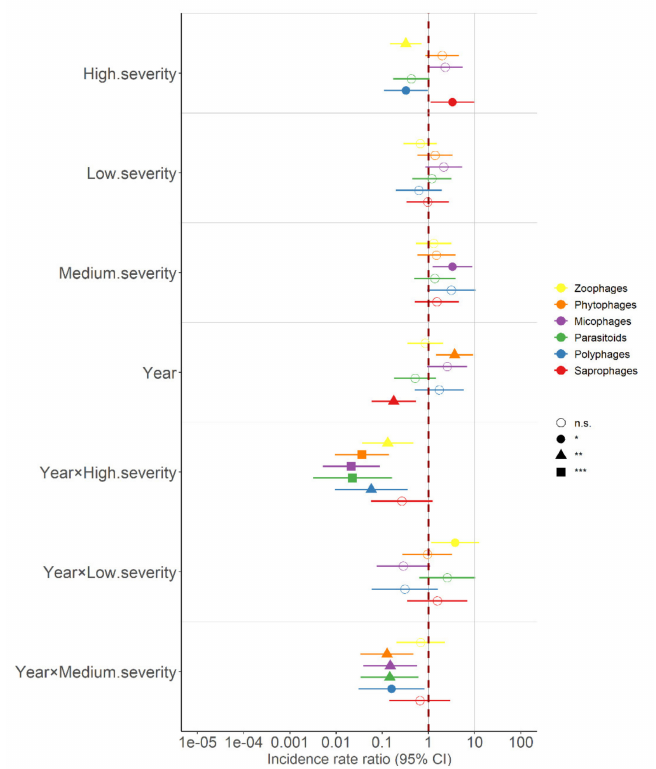
Figure 4. Incidence rate ratio (IRR) of GLMM fixed-effect coefficients for the effects of wildfire treatments (low severity, medium severity, and high severity), year, and the interaction of both factors on the abundance of arthropod guilds. IRR values represent the difference in the logs of expected abundance when the predictor variable changes in one unit. Significant effects are those where the intervals of coefficients do not intersect the red line (IRR = 1). Coefficients for the first year and unburned (control) treatment were considered as contrasts (assigned with the value 0) to test for differences among the levels of those